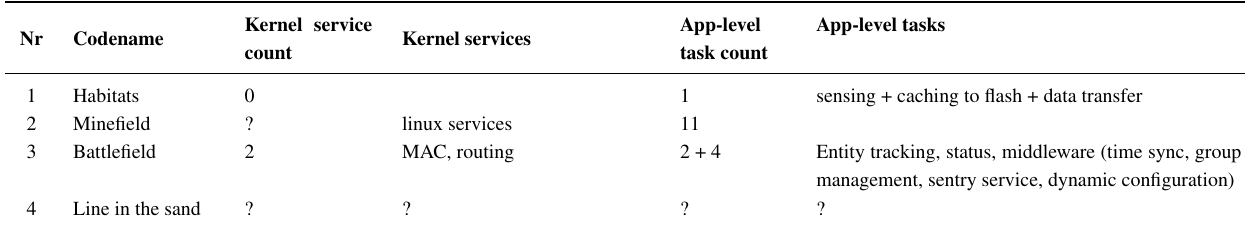
Table 14. Deployments: software level